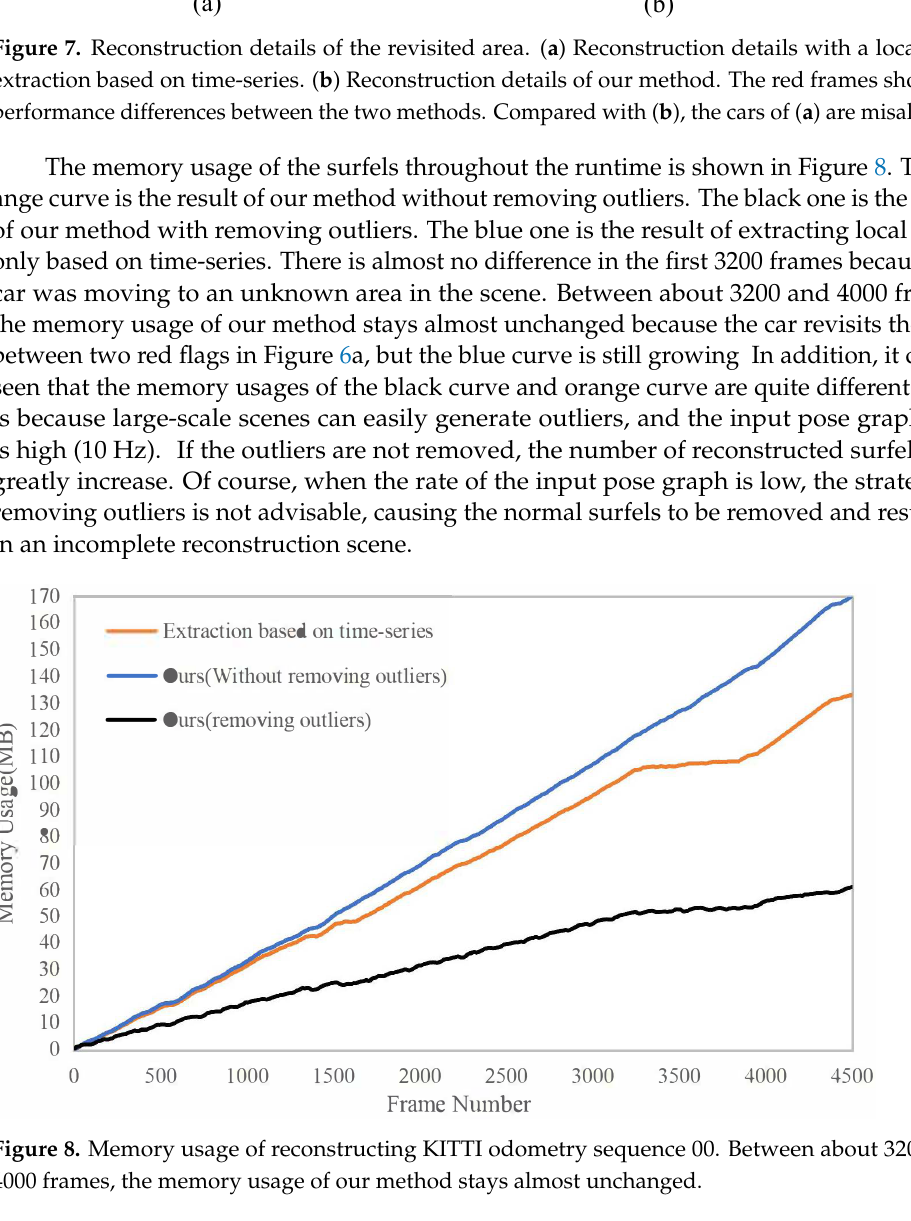
Figure 8. Memory usage of reconstructing KITTI odometry sequence 00. Between about 3200 and 4000 frames, the memory usage of our method stays almost